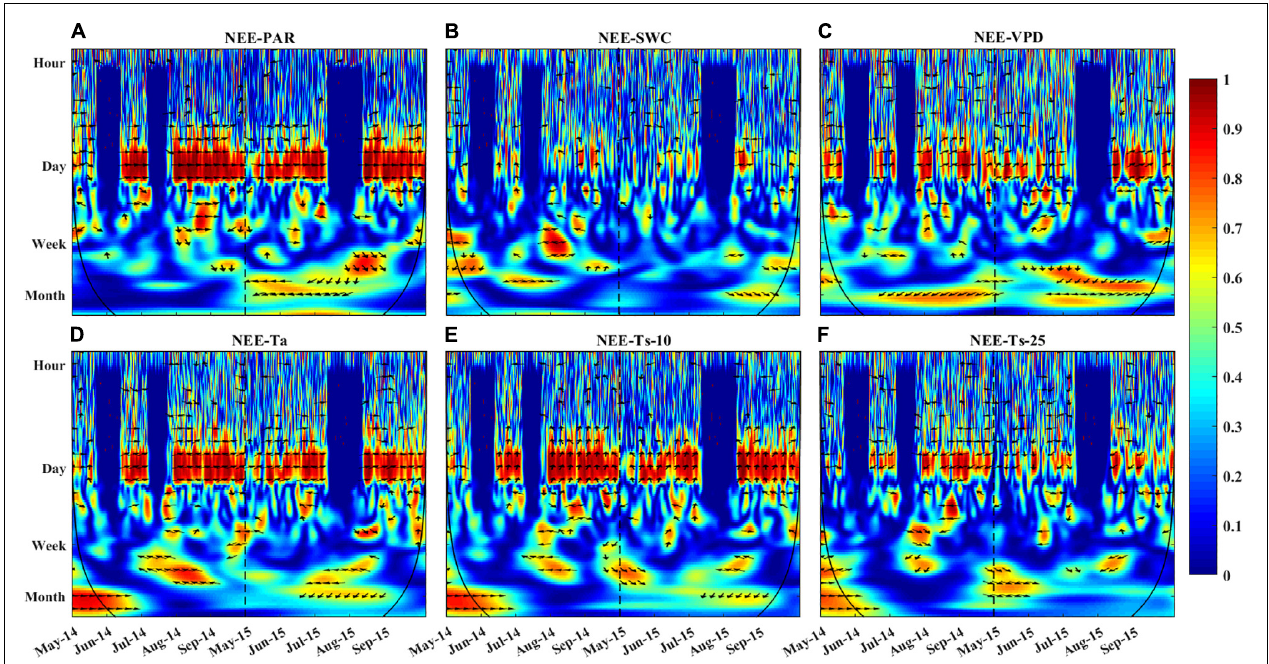
FIGURE 8 | Wavelet coherence between NEE and (A) PAR, (B) SWC, (C) VPD, (D) Ta, (E) Ts-10, and (F) Ts-25. Red color indicates a high correlation between NEE and variables on the given time scale. The direction of arrows represents phase shift between NEE and associated variables (right: NEE and variables are in phase, which means the series are perfectly correlated; up: NEE leads variable by π /2; left: NEE and variables are out of phase; down: NEE lags variable by π /2). The black line represents the cone of influence, beyond which edge effects are abundant and results should be interpreted with caution. The dotted line is used to distinguish the growing season of 2014 and 2015.